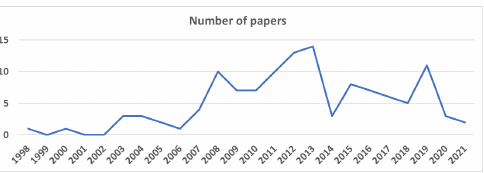
Figure 11. Chronological evolution of the number of papers about LPV for suspension systems (total number = 121 papers).